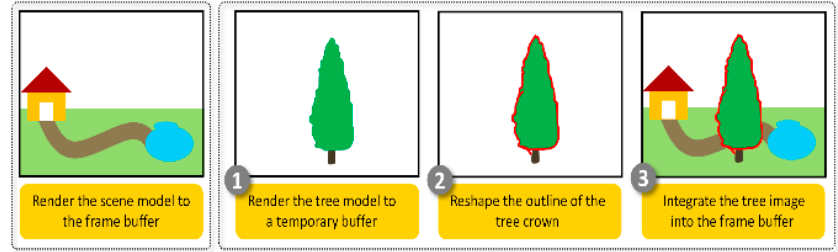
Figure 14. Basic process of rendering control per frame.